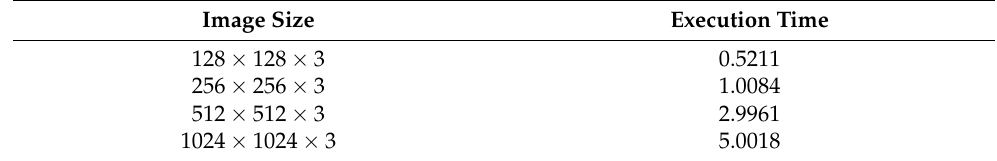
Table 7. Execution time (in seconds) of the proposed cryptosystem. Image Size